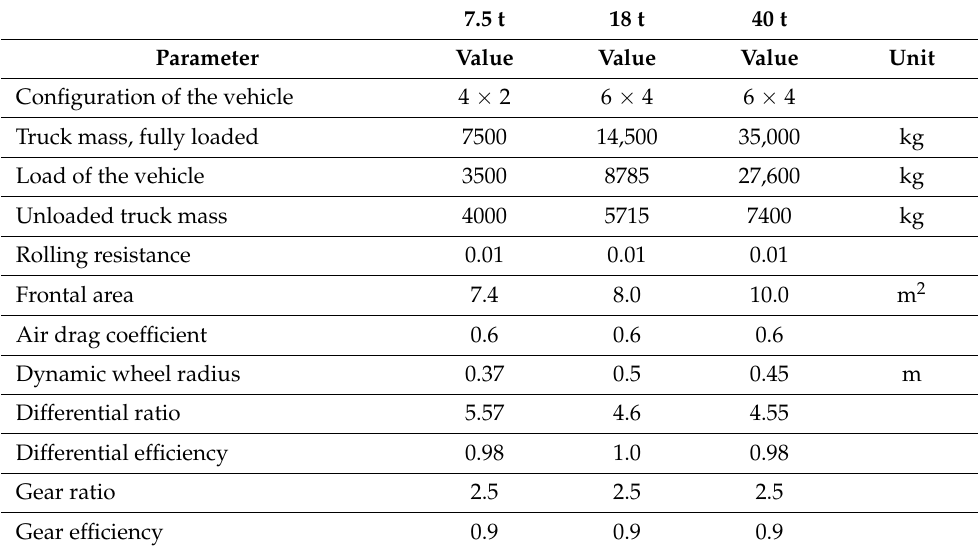
Table 3. Overview of the vehicle and powertrain parameters used in the evaluation of the 7.5 t, 18 t, and 40 t